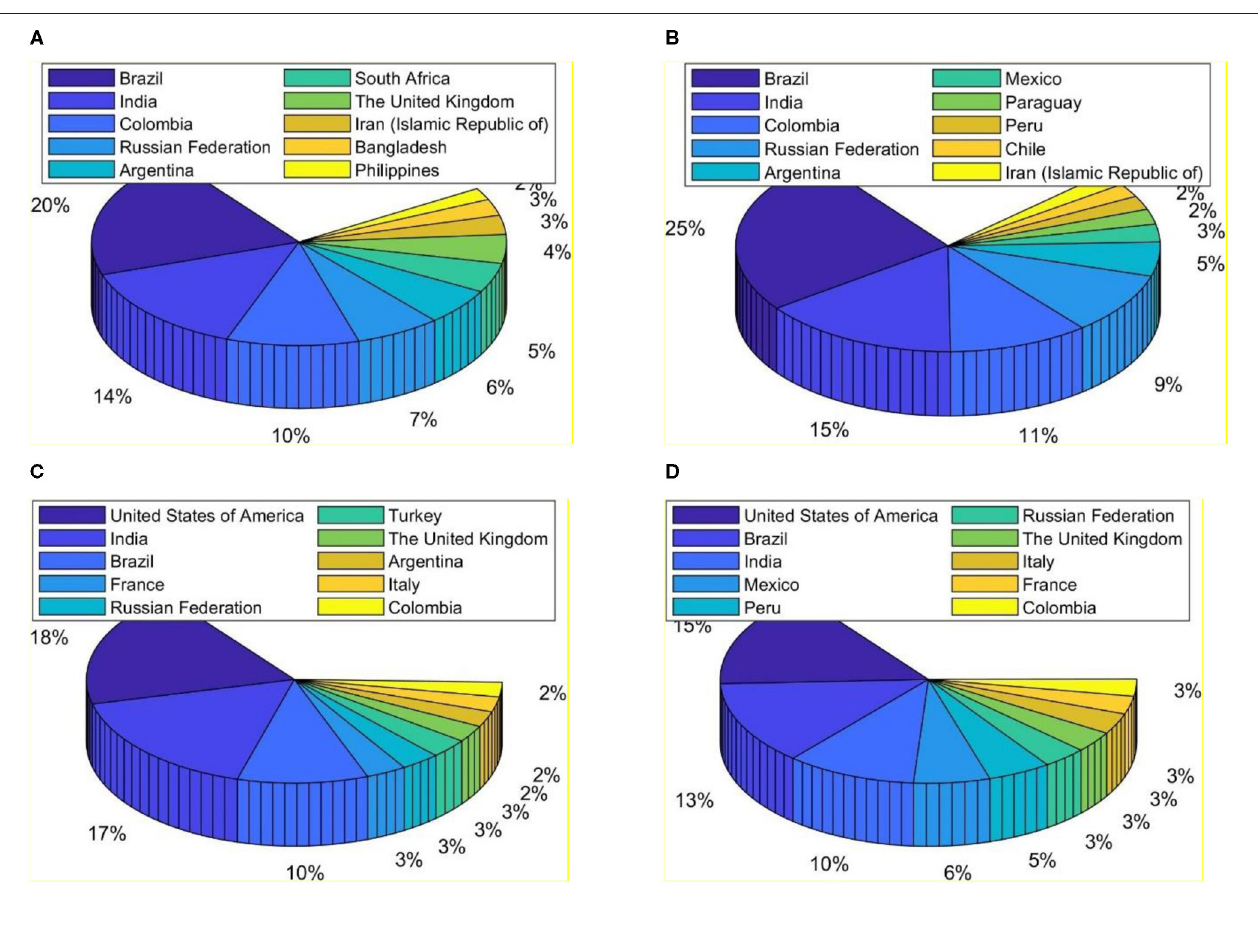
FIGURE 1 | Pie charts of the top 10 countries. (A) New cases, (B) new death tolls, (C) cumulated cases, and (D) cumulated death